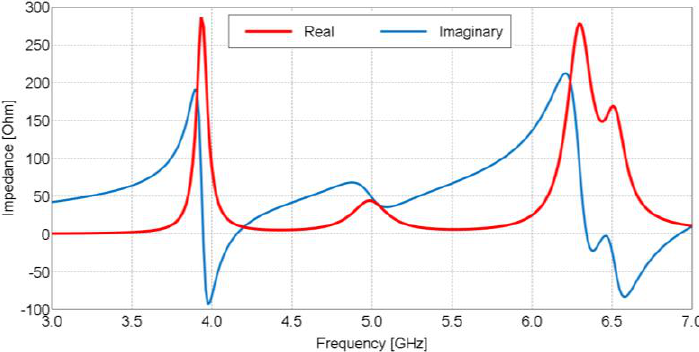
Fig. 4. Radiation patterns of single radiator in polar coordinates at frequencies of 4.75 GHz (a), 5 GHz (b) and 5.25 GHz